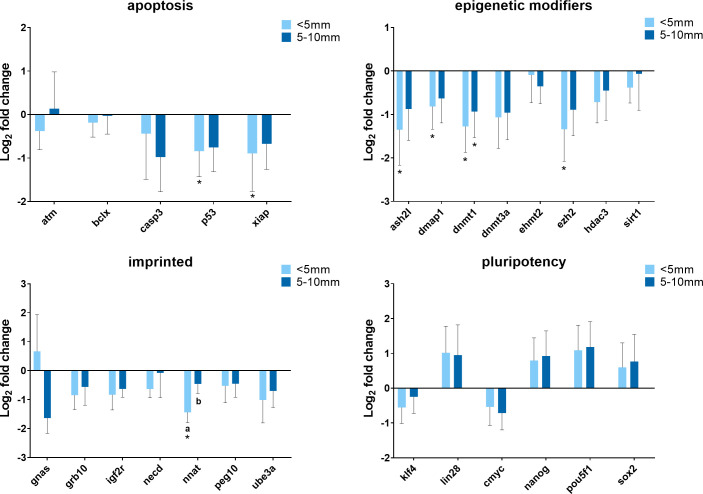
Summary of relative gene expression levels in fibroblast cells of Chamber I from different distal locations.Cells were exposed to electrical biostimulation (380 nA) for 21 hours, and collected from different locations: immediately adjacent (within 5 mm) to the silver electrode; 5–10 mm distal from the electrode; and 15–20 mm distal from the electrode (the control). Graphs depicting the average log2 fold change values of every gene for each of the functional gene categories tested by qPCR using the BioMark system from Fluidigm. In each of these graphs, error bars reflect the standard error of the mean log2 fold change values calculated for four replicate reactions. * = significantly different from the control (the cells in 15–20 mm distal from the electrode). a,b,c = within a panel (gene category), different superscripts denote statistically significant differences in log2 fold change values between samples (P < 0.05).